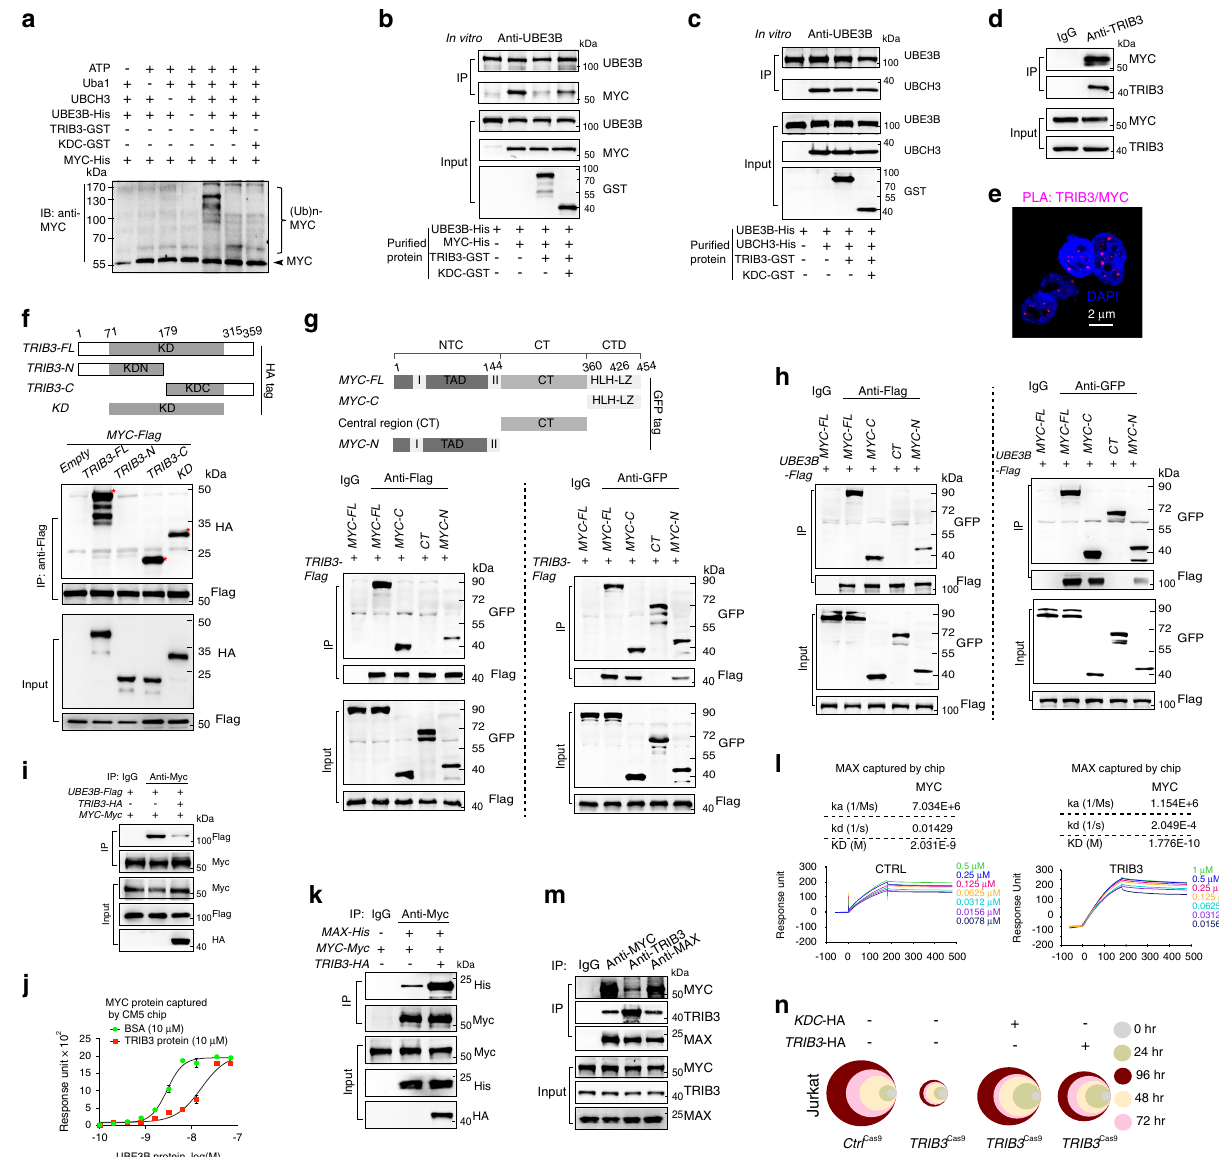
Fig. 5 TRIB3 interacts with MYC to inhibit the UBE3B:MYC axis. a In vitro ubiquitination assays show that the TRIB3 or TRIB3-KDC protein decreased polyubiquitination of MYC mediated by UBE3B and UBCH3. b The TRIB3 protein or the KDC domain of TRIB3 decreased the interaction of MYC and UBE3B in the puri fi ed system. c Neither the TRIB3 protein nor the KDC domain of TRIB3 affected the interaction of UHCH3 and UBE3B in the puri fi ed system. d The interaction of TRIB3 and MYC in Raji cells was evaluated by Co-IP assays. e Colocalization of TRIB3 and MYC in Raji cells was detected with immunostaining (PLA assay). Data are representative images from three independent experiments. Scale bar, 2 μ m. f Mapping TRIB3 regions binding to MYC. Top: deletion mutants of TRIB3. Bottom: HEK 293T cells were cotransfected with the indicated constructs of TRIB3 (HA tag) and MYC (Flag tag). Cell extracts were IP with an anti-Flag Ab. g , h Mapping MYC regions binding to TRIB3 ( g ) or UBE3B ( h ). Top: deletion mutants of MYC. Bottom: HEK293T cells were cotransfected with the indicated constructs of MYC and TRIB3 or UBE3B. Cell extracts were IP with an anti-Flag Ab. i TRIB3 overexpression interfered with the interaction of UBE3B and MYC. HEK 293T cells were cotransfected with the indicated constructs. Cell extracts were IP with an anti-MYC Ab. j TRIB3 decreased the binding of UBE3B and MYC. Kinetic interactions of the UBE3B and MYC proteins were determined by SPR analyses with the BSA or TRIB3 proteins. k TRIB3 overexpression increased the interaction of MAX and MYC. HEK 293T cells were cotransfected with the indicated constructs. Cell extracts were IP with an anti-MYC Ab. l TRIB3 overexpression increased the binding of MAX and MYC. Kinetic interactions of the MAX and MYC proteins were determined by SPR analyses with the CTRL (GST) or TRIB3 (TRIB3-GST) protein. m The heterotrimers of MYC, TRIB3, and MAX in Raji cells were detected by Co-IP assays. Cellular extracts were IP with mouse IgG as a negative control or anti ‐ MYC, anti ‐ TRIB3, or anti-MAX antibodies. Western blots were performed with anti ‐ MYC, anti ‐ TRIB3, and anti-MAX antibodies. n Recovery of the TRIB3 -HA wild-type or KDC -HA mutant enhanced the decreased cell viabilities of TRIB3 Cas9 Jurkat cells for the indicated times. The colors represent different time points; the diameter indicates the relative cell viability. Source data are provided as a Source Data fi